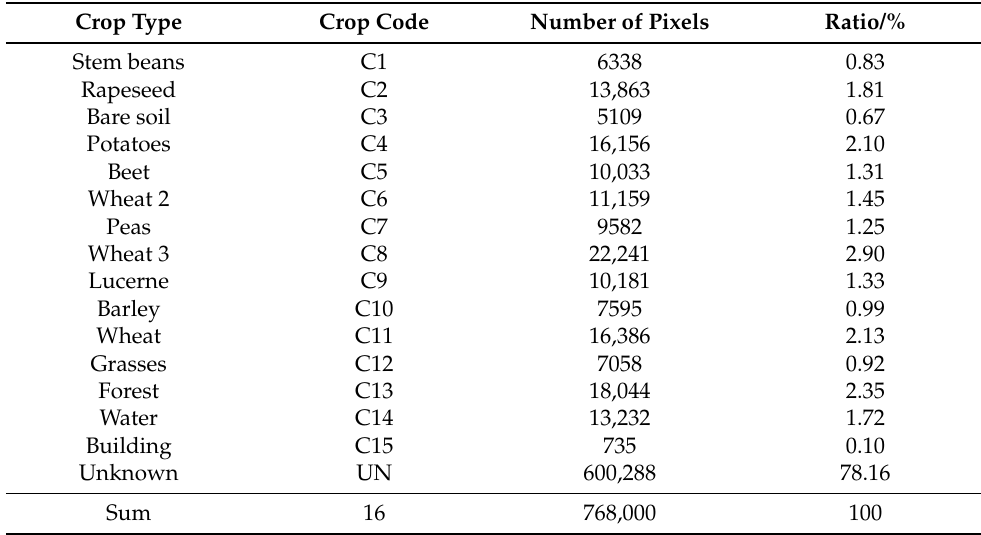
Figure 6. Images of the study area. ( a ) Pauli image. ( b ) Ground truth. Table 3. Main Crops in the Study